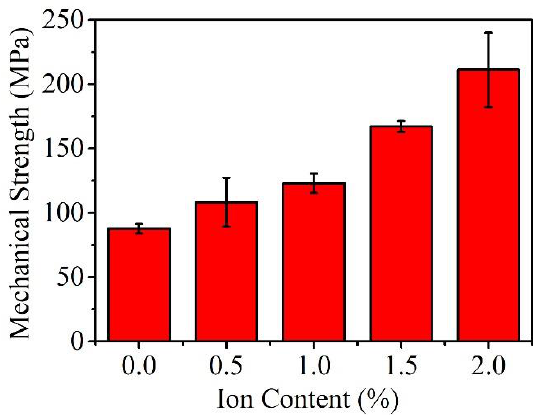
Figure 7. Membrane tensile strength of pure PVA and modified PVA samples with various contents of ferric ions.